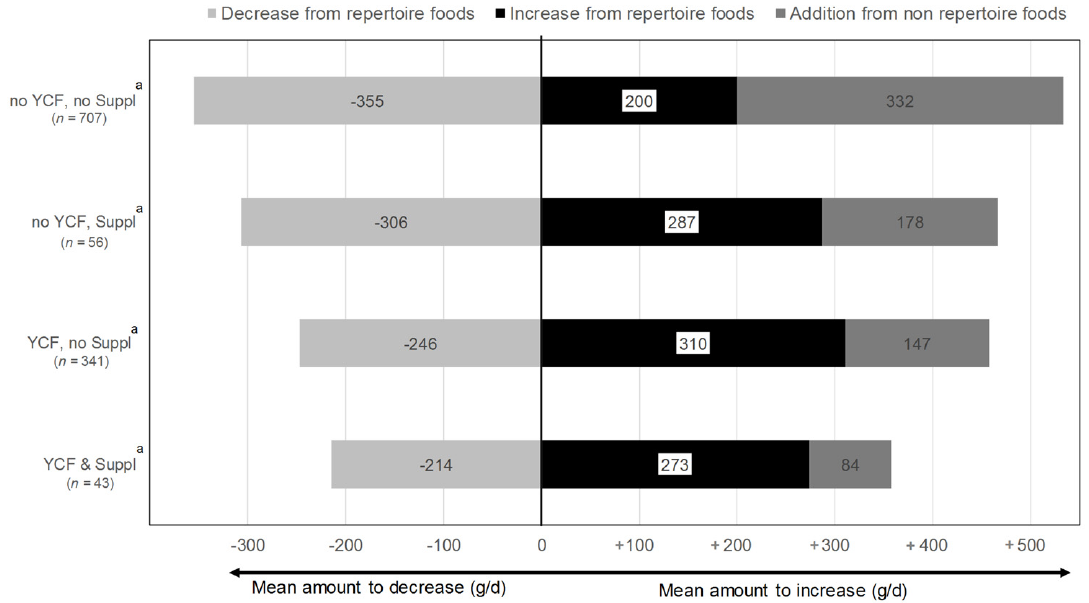
Figure 2. Variations in food quantities between diets modeled (all-foods models b ) and observed diets, across the four groups of children * , **. a “No YCF, no Suppl” refers to children who did not consume either YCFs or supplements during the four days of dietary record; “no YCF, Suppl” refers to those who did not consume YCFs, but who consumed supplements; “YCF, no Suppl” refers to those who consumed YCFs, but not supplements; “YCF & Suppl” refers to those who consumed both YCFs